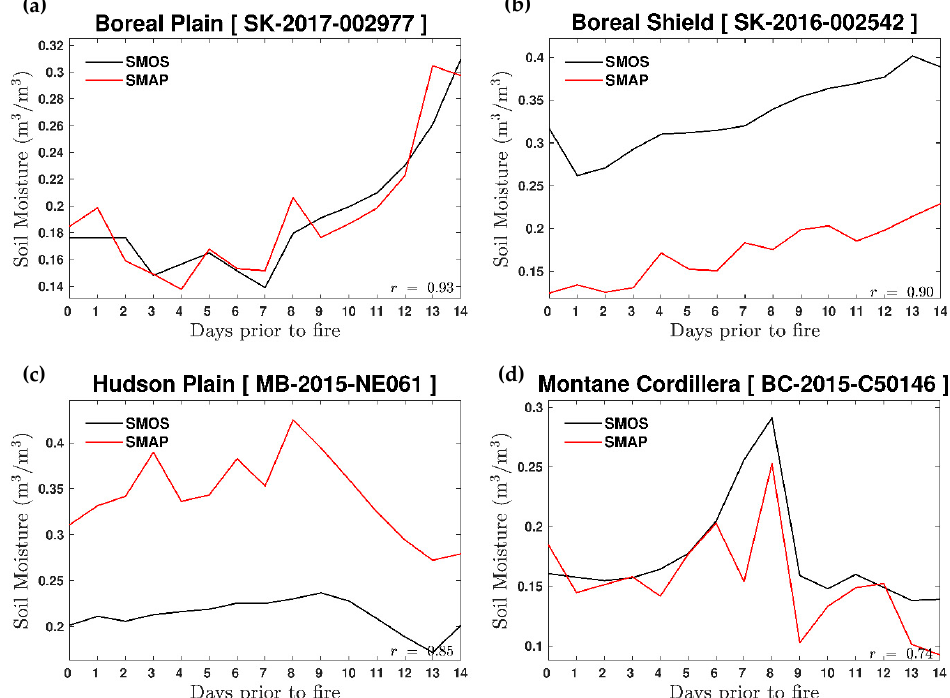
Figure 3. SMOS (Soil Moisture and Ocean Salinity) and SMAP (Soil Moisture Active Passive) soil moisture time series over two weeks period prior to the onset of fire, for four randomly selected fires in, Boreal Plain ( a ), Boreal Shield ( b ), Hudson Plain ( c ), and Mountane Cordillera ( d ). The unique fire identifier is indicated in square brackets on the figure subtitles. r is the correlation between SMOS and SMAP soil moisture.